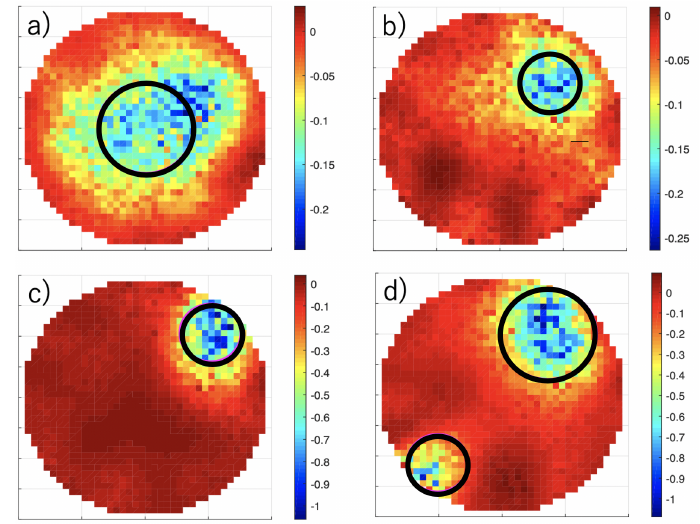
Figure 10. Electrical conductivity indicator function. Two non-conductive rods of diameter 20 and 30 mm, shown with black circles, are inserted in the test section filled with salt water. ( a ) A 30-mm rod at the center. ( b ) A 20-mm rod half way to the edge. ( c ) A 20-mm rod on the edge. ( d ) Two rods on the